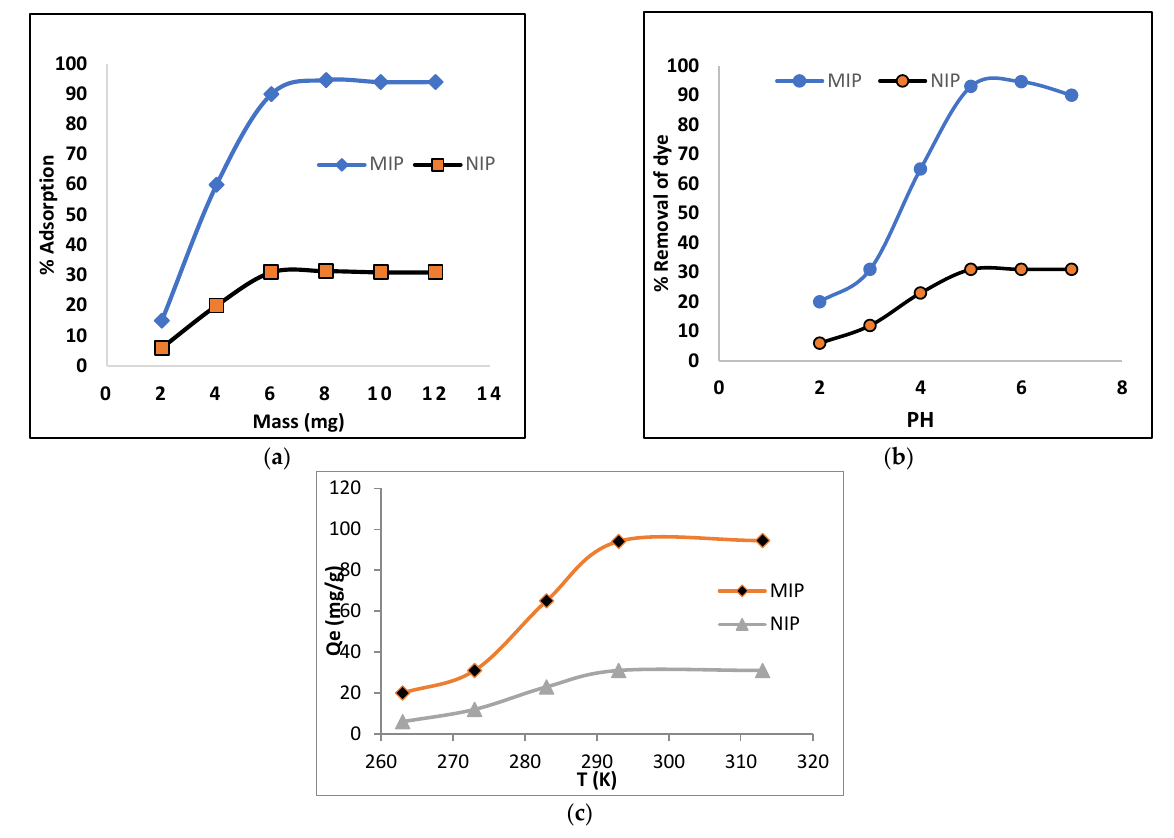
Figure 4. Effect of mass ( a ), pH ( b ) and temperature on adsorption of AB-234 dye on the MIP and NIP ( c ) .